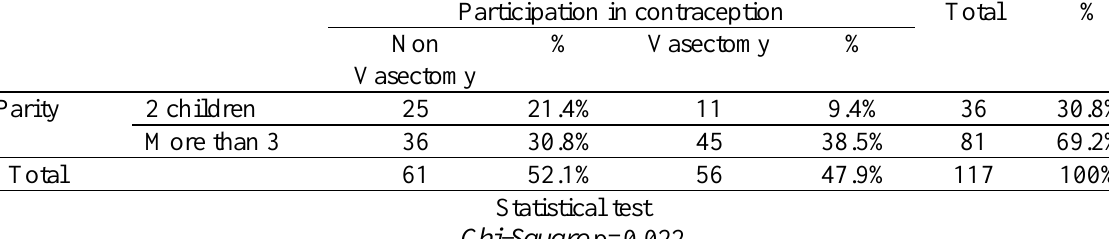
Table 3 The correlation between the number of children with vasectomy selection